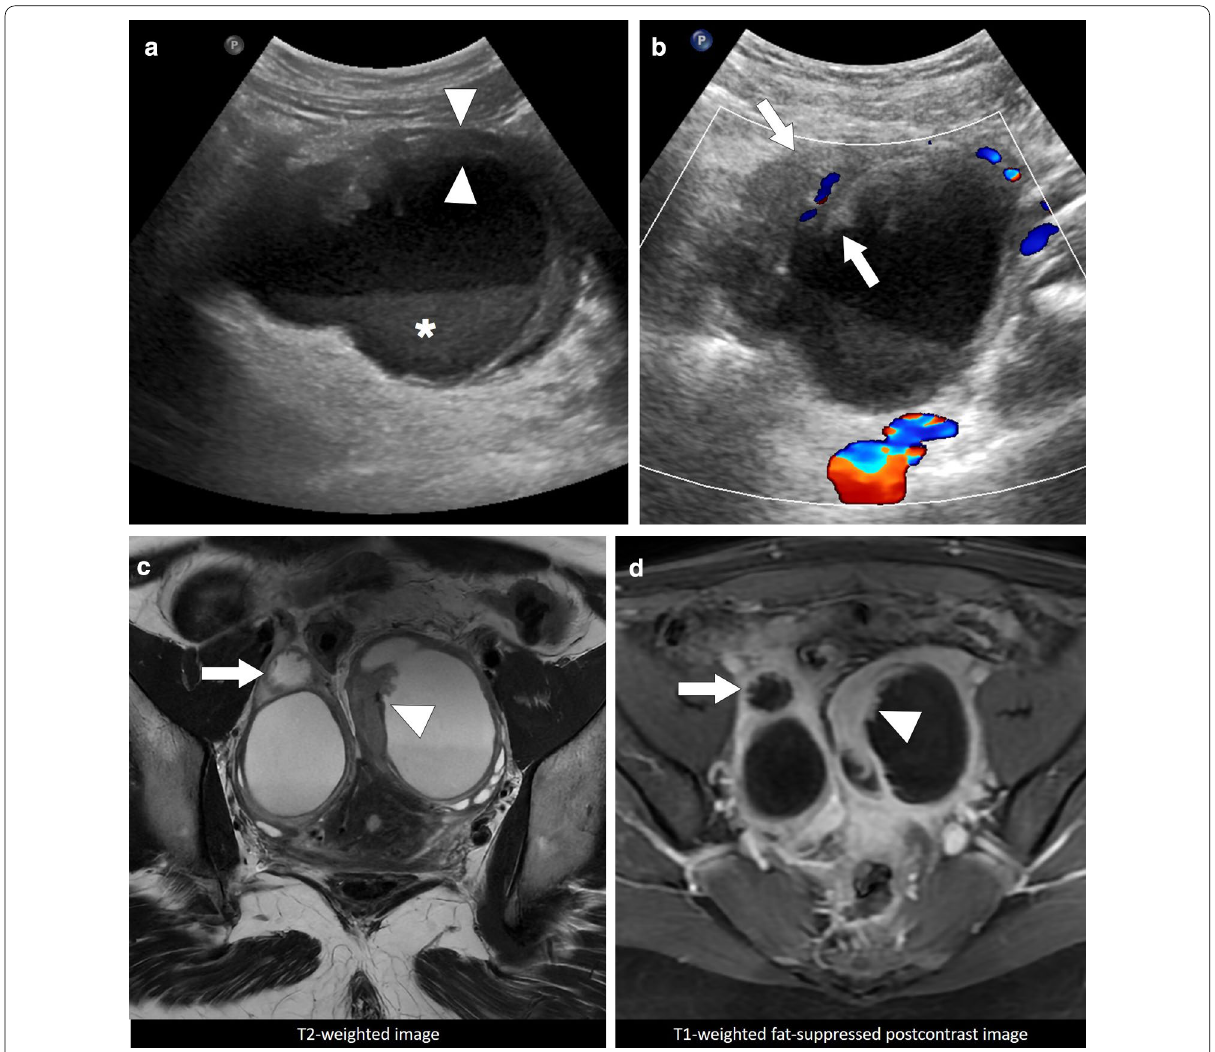
Fig. 26 Bilateral adnexal inflammatory pseudotumor. A 25-year-old female with progressively increasing dull pain in lower abdominal quadrants which started 4–6 weeks before her initial presentation. Physical examination revealed mild abdominal tenderness and suspicious palpable masses in the pelvis without fever. Serum CA-125 level was 250 U/mL (N: 0–35 U/mL), and an ovarian malignancy was suspected based on the clinical